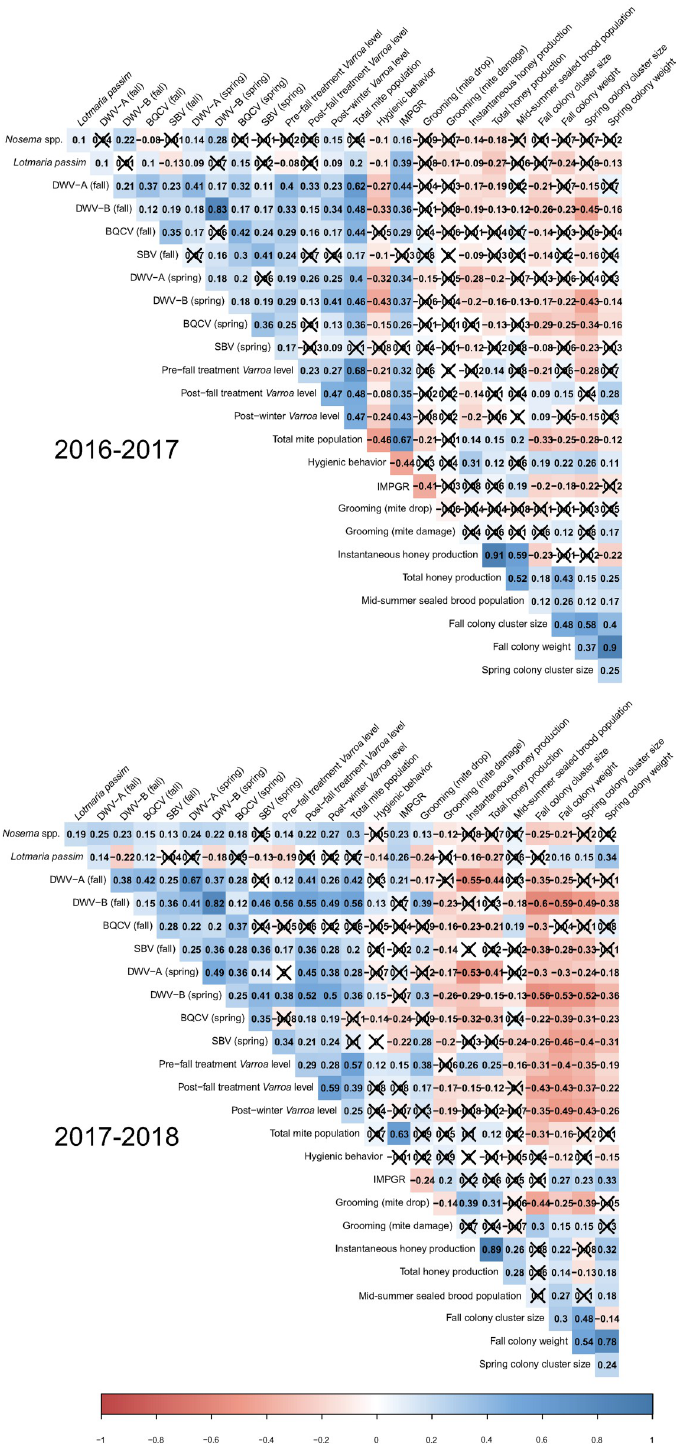
Fig 3. Pathogen and colony phenotypes correlation matrix using Spearman’s rho statistic with Bonferroni correction for multiple tests. Correlation coefficients (reported as R values) are shown for each pair-wise comparison. Statistically insignificant estimates ( P > 0.05) are marked with an ‘X’. Shaded blue cells represent positive correlations and red cells represent negative correlations. Darker hues indicate stronger correlations as indicated by the correlation color